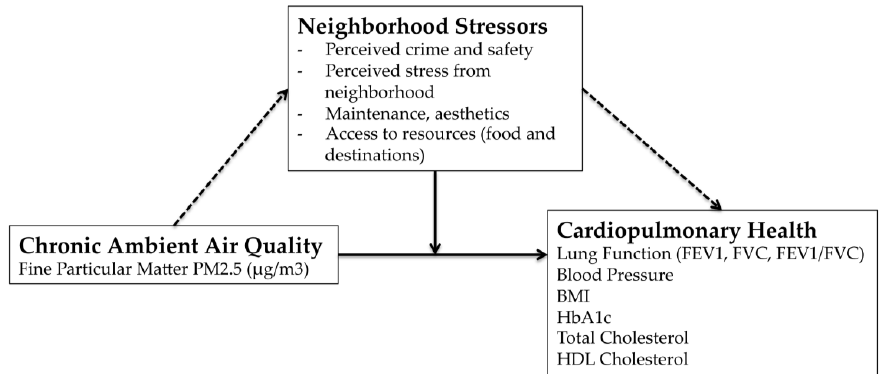
Figure 1. Conceptual model linking pathway of air pollution exposure, perceived neighborhood stressors and cardiopulmonary health.